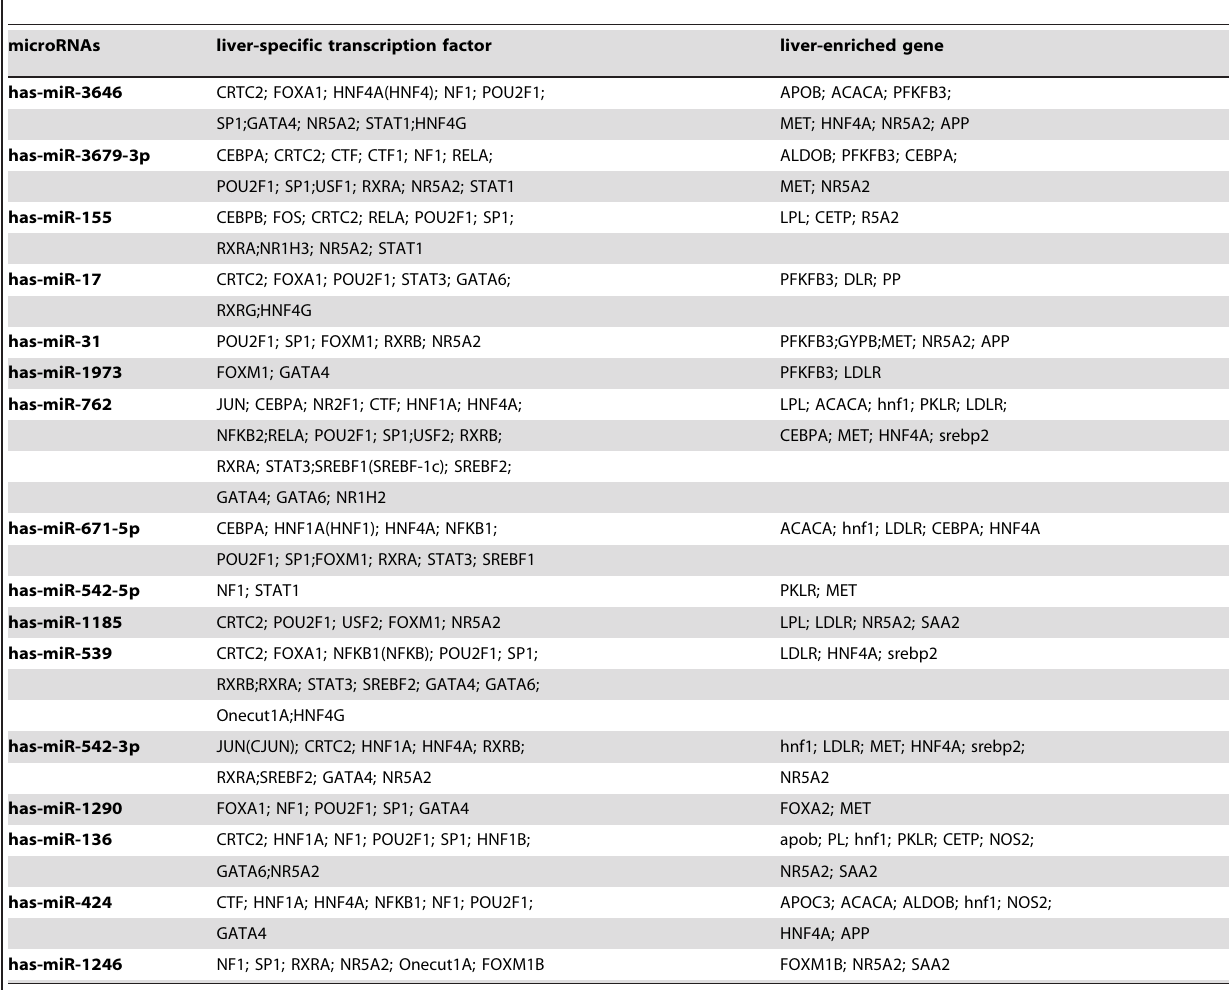
Table 2. Liver-specific transcription factors and liver-enriched genes that are potentially targeted by altered microRNAs as predicted by TargetScan